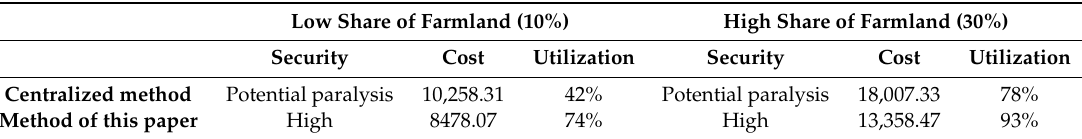
Table 6. Scenario comparison based on farmland